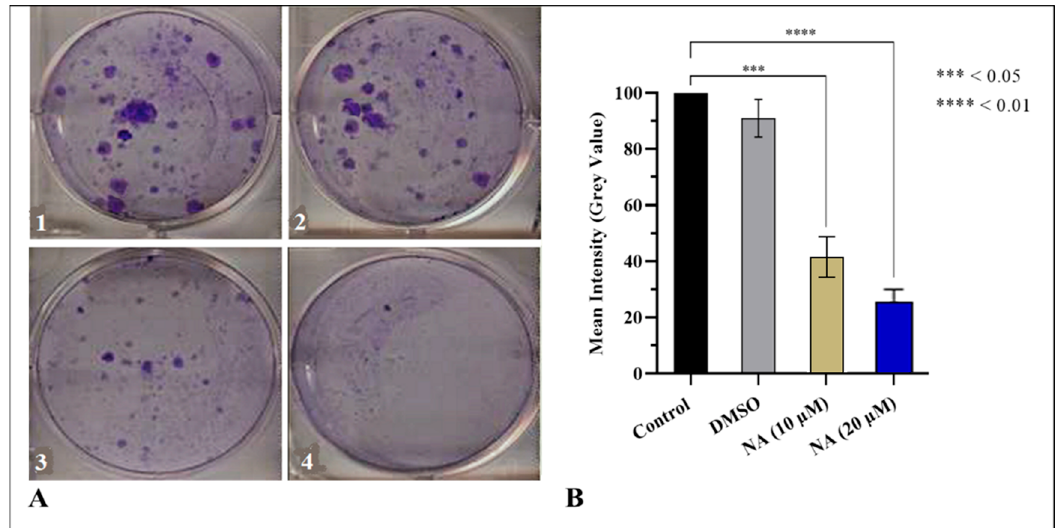
Figure 4. Inhibition of colony formation by NA in prostate cancer cell lines. Note: DU145 cells were treated with 10 µM and 20 µM concentrations of NA for 48 h and then allowed to form colonies for 5–7 days. ( A ) Pictures of colonies for DU145 cell lines were taken using Olympus CKX41 micro- scope: (1) Control, (2) 1% DMSO, (3) NA (10 µM), and (4) NA (20 µM). ( B ) Densitometry analysis of colonies was performed in control and treated wells. Data are mean ± SEM ( n = 3) of colony intensities measured using ImageJ